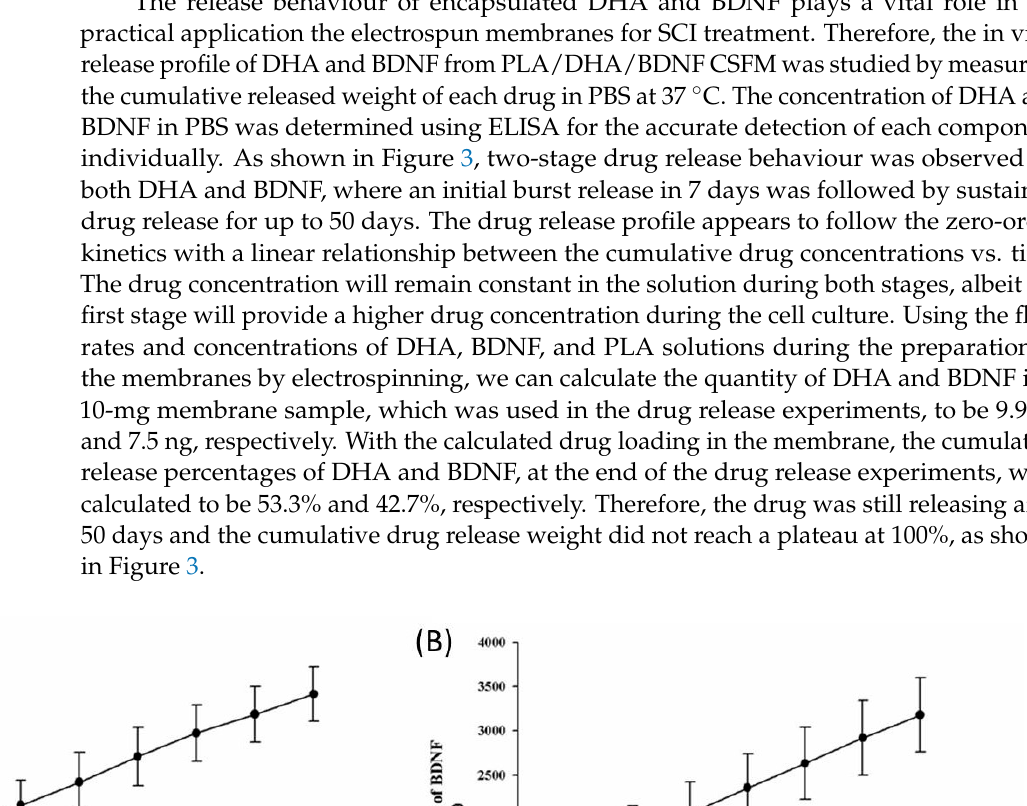
Figure 4. The cytotoxicity of PLA, PLA/DHA, and PLA/DHA/BDNF core–shell fibrous membranes (CSFMs). The fibroblasts were cultured with 24-h extract of a CSFM. The cell viability was compared with fibroblasts cultured with fresh cell culture medium (control), which was taken as 100%. The